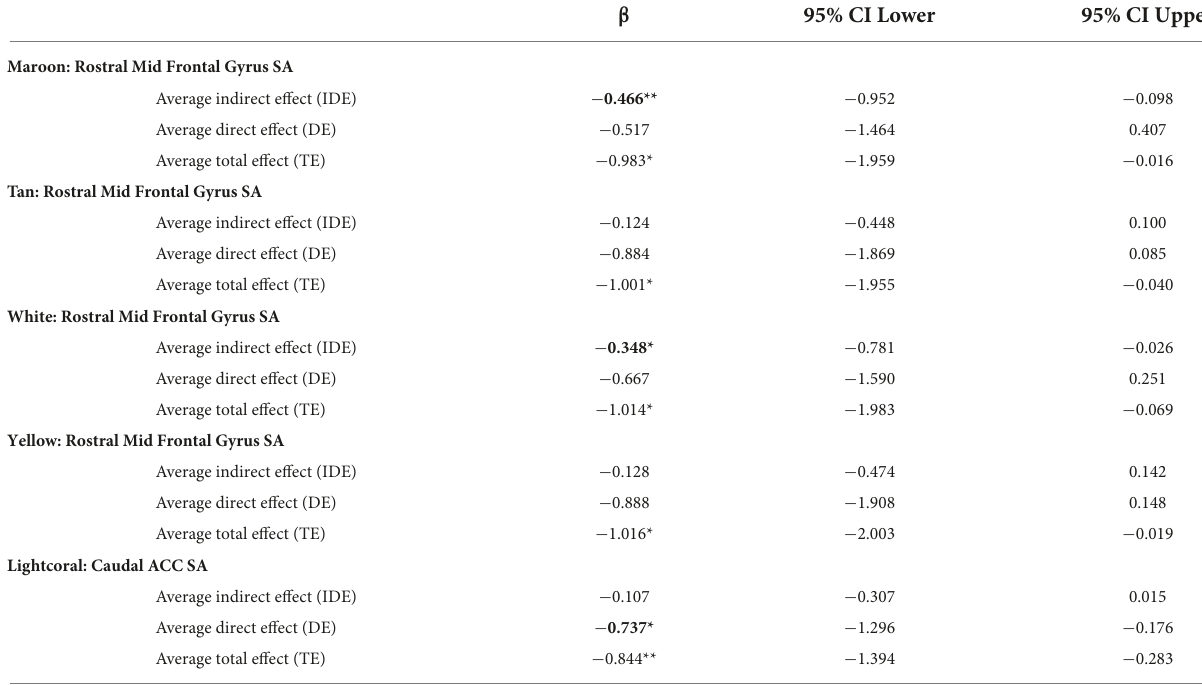
TABLE 3 Module eigengenes (MEs) mediating observed adverse social exposure (ASE), fronto-limbic brain morphometry relationships. β 95% CI Lower